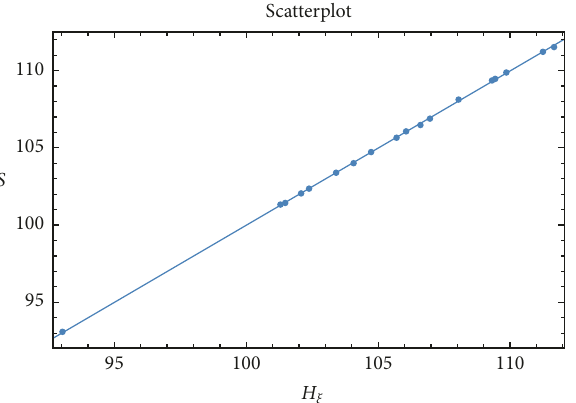
superimposed by the fitted ξ